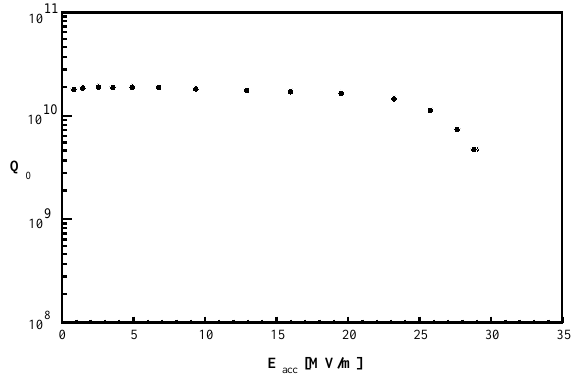
FIG. 12. Excitation curve of the best TESLA 9-cell cavity measured to date. The cavity was cooled by superfluid helium of 2 K. (cid:1) f (cid:1) D f , where f is the 12 The quality factor is defined as Q 0 resonance frequency and D f is the full width at half height of the resonance curve of the “unloaded”